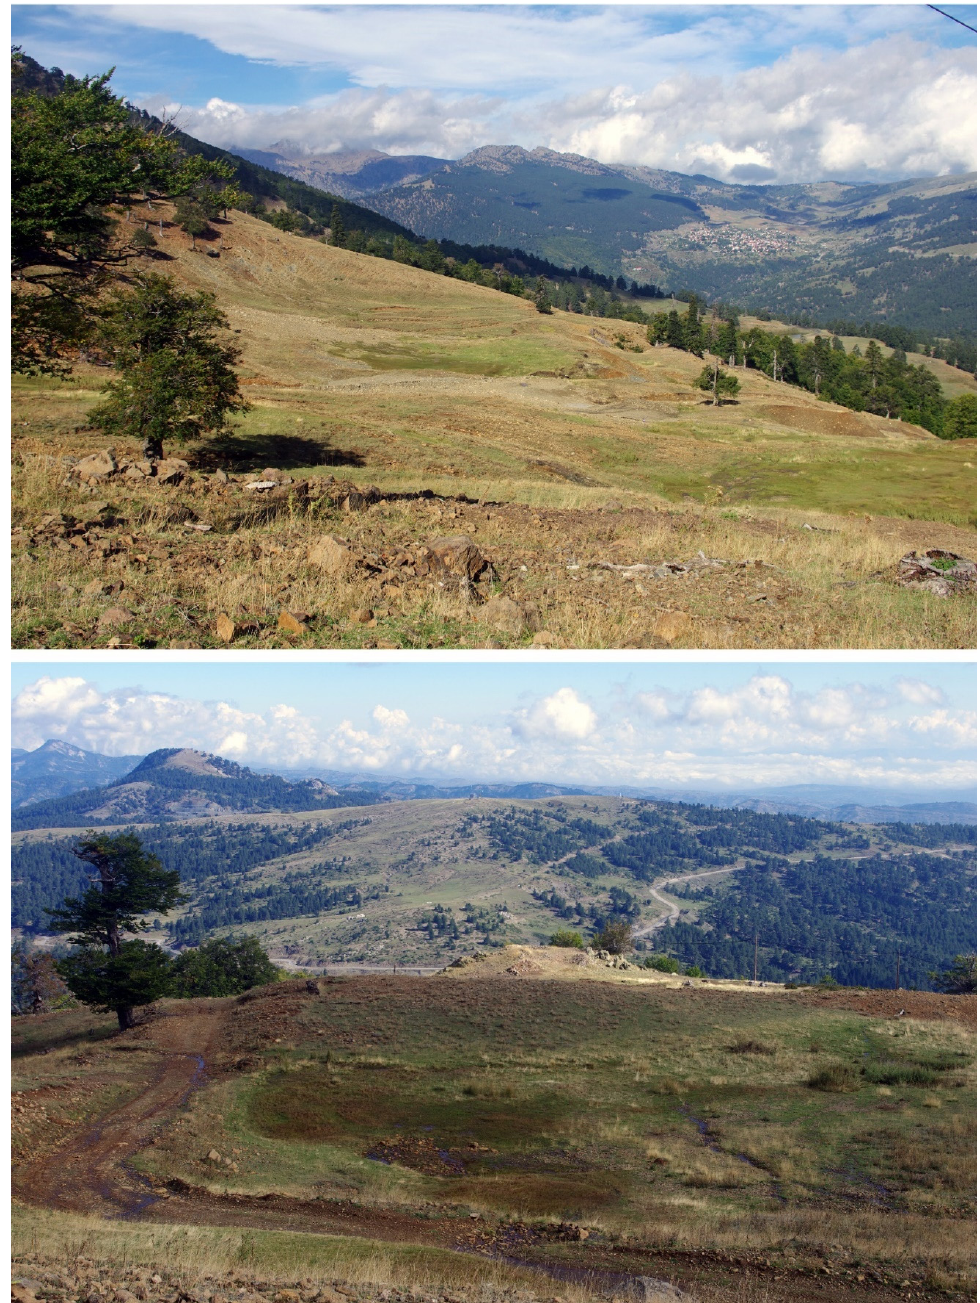
Figure 15. Panoramic view of the archaeological sites discovered along the northern slopes of Mount Baltoumis: VSL 1 ( top ), and VSL 2 with Mount Anitsa in the background ( bottom ) (photographs by P. Biagi, 2019).